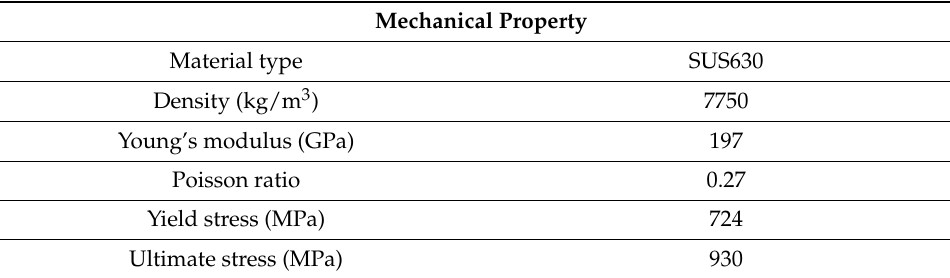
Table 2. Material parameters of TRT rotor.